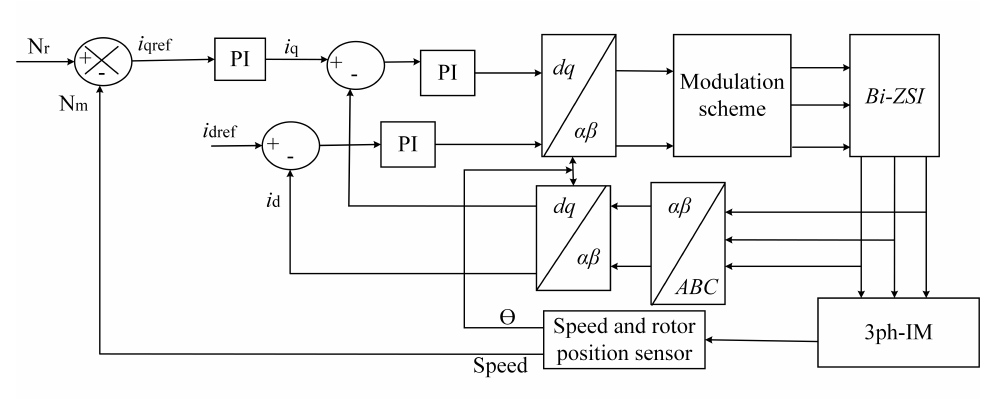
Figure 7. Control scheme of the Proposed fault-tolerant strategy.